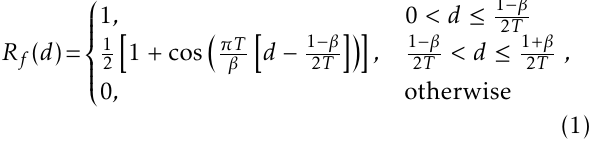
Figure 8. The value of remembrance factor R elapsed days d , T = 1